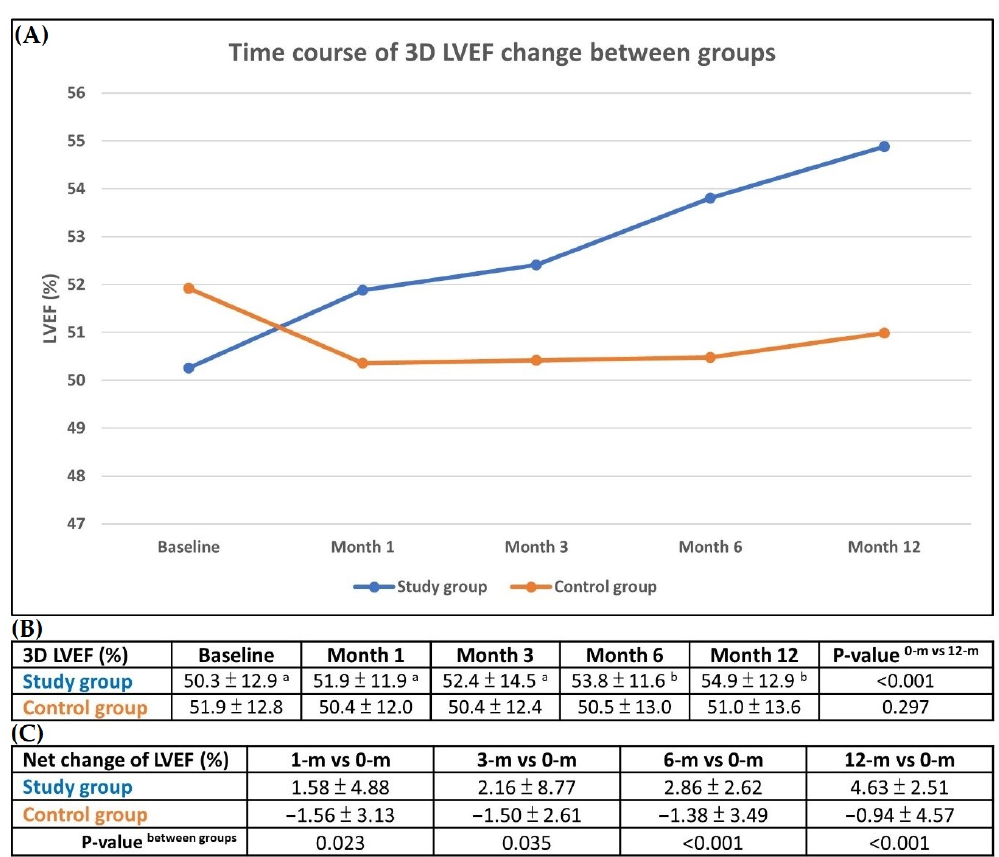
Figure 4. Individual and mean changes of LVEF between baseline and 12 months, and serial changes of LVEF on 3-D echocardiographic findings during 1-year follow-up. ( A ) Illustrating the time courses of 3-D transthoracic echocardiographic findings of left ventricular ejection fraction (LVEF) among group 1 and group 2 patients. The results demonstrated that the LVEF was notably stepwise increased during the follow-up time points at 0, 1, 3, 6 and 12 months in group 1 patients. However, this parameter showed initially downwards, followed by stationary no more change in group 2 patients. ( B ) Compared with baseline (i.e., 0 month), the LVEF was significantly increased among group 1 patients, p < 0.001, but it showed no di ff erence among group 2 patients, p = 0.29. ( C ) Illustrating the net LVEF improvements at di ff erent time points were significantly higher in group 1 than in group 2. Increases in the net change of LVEF improvement in group 1 as compared to group 2 at the time intervals between baseline vs. 1 month: + 1.58 ± 4.88 vs. − 1.56 ± 3.13, p = 0.023; 3 month: + 2.16 ± 8.77 vs. − 1.50 ± 2.16, p = 0.035; 6 month: + 2.86 ± 2.26 vs. − 1.38 ± 3.49, p < 0.001; 12 month: + 4.63 ± 2.51 vs. − 0.94 ± 4.57, p <